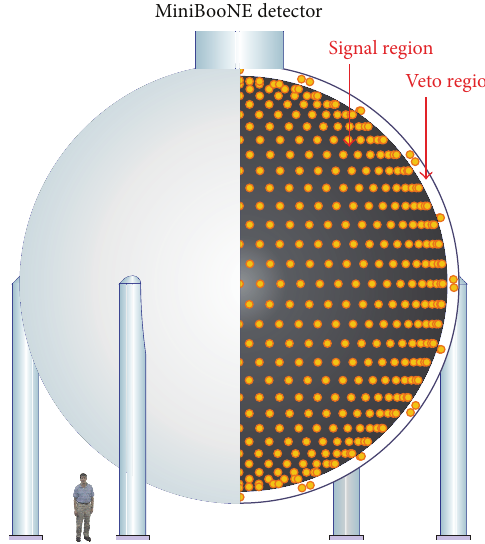
Figure 9: A schematic drawing of the MiniBooNE detector.